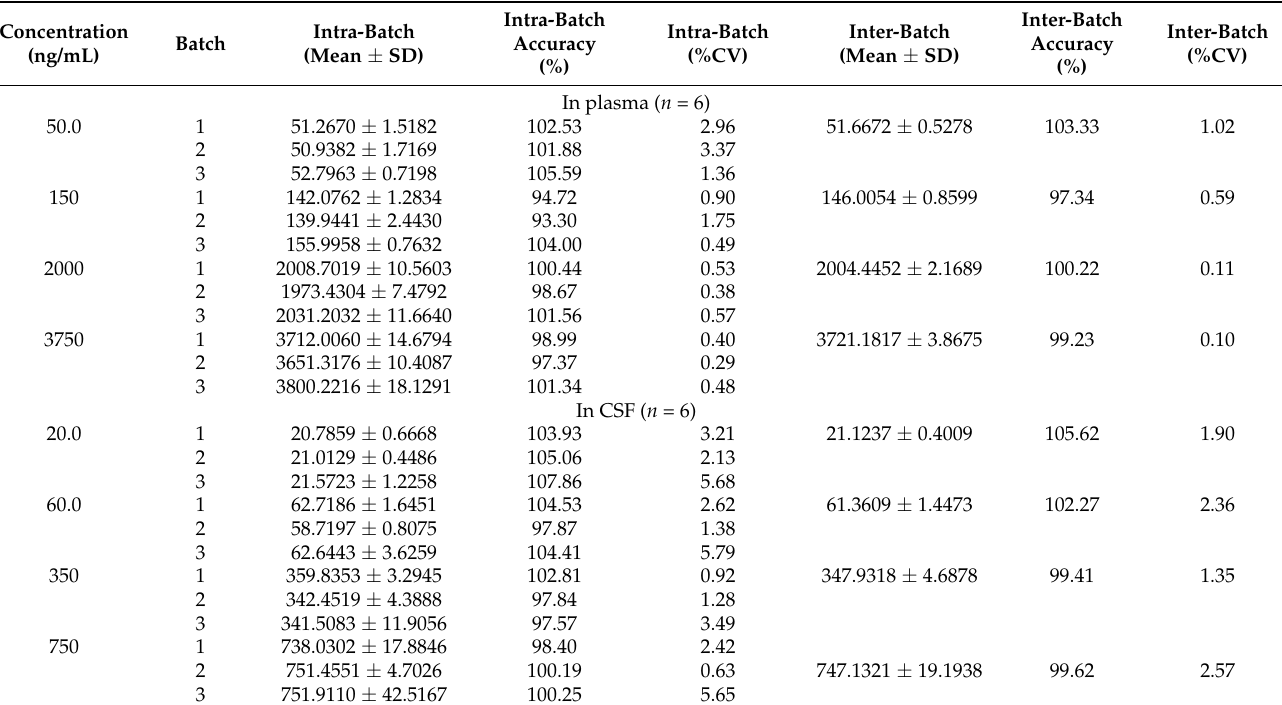
Table 2. Precision and accuracy of the method for determining contezolid.